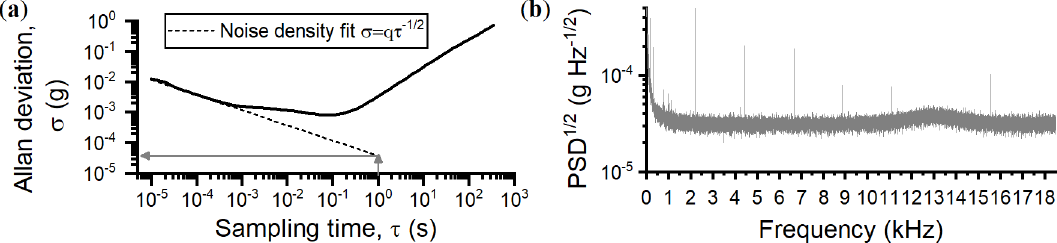
Figure 4. ( a ) The Allan deviation of the WGM accelerometer prototype where the dashed line is the noise density fit. The value of the fit at τ = 1s is a measure of the noise density σ = 37 µ gHz − 1/2 . ( b ) The noise density, as measured on the PSD, is the flat noise floor below the microsphere-cantilever mechanical peak. It increases above σ = 37 µ gHz − 1/2 for frequencies below 1kHz and frequencies around the mechanical peak. The sharp peaks are electronic